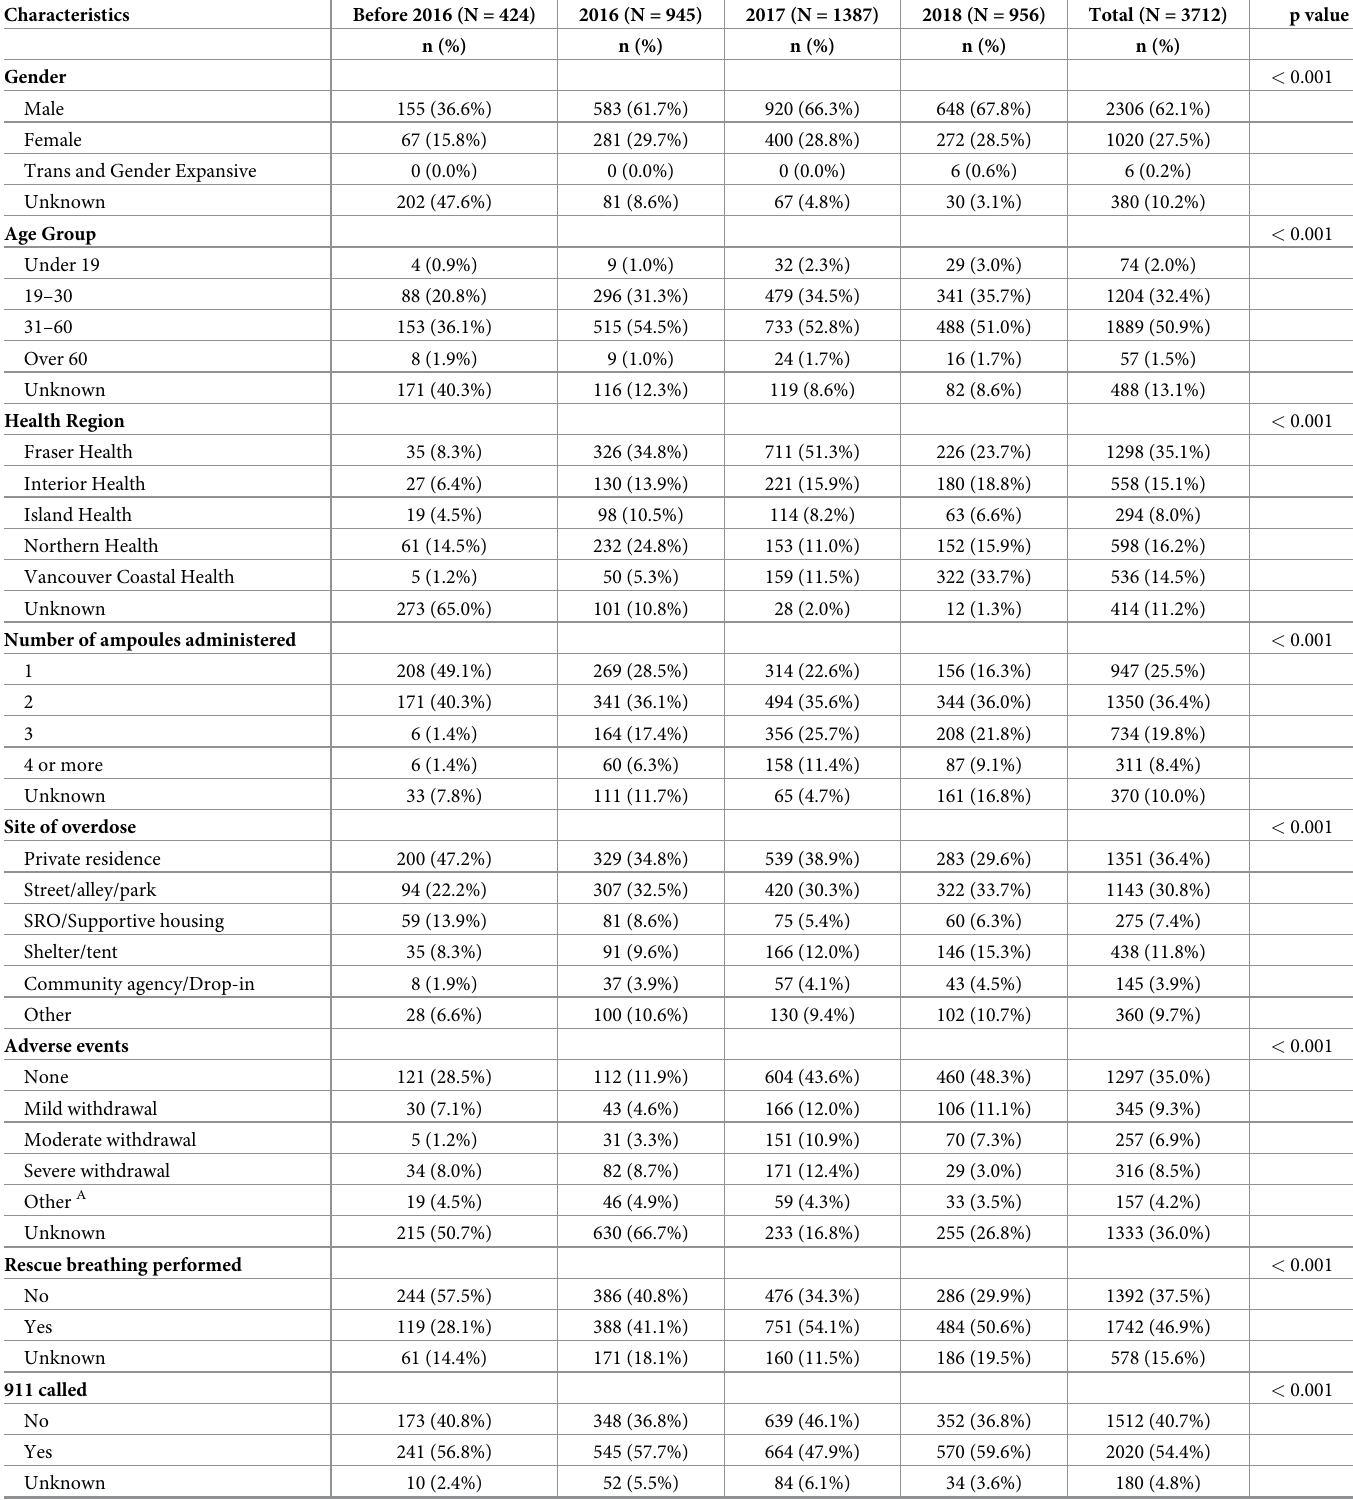
Table 1. Summary characteristics of Naloxone Administration Data, from program inception on August 31 2012 to December 31